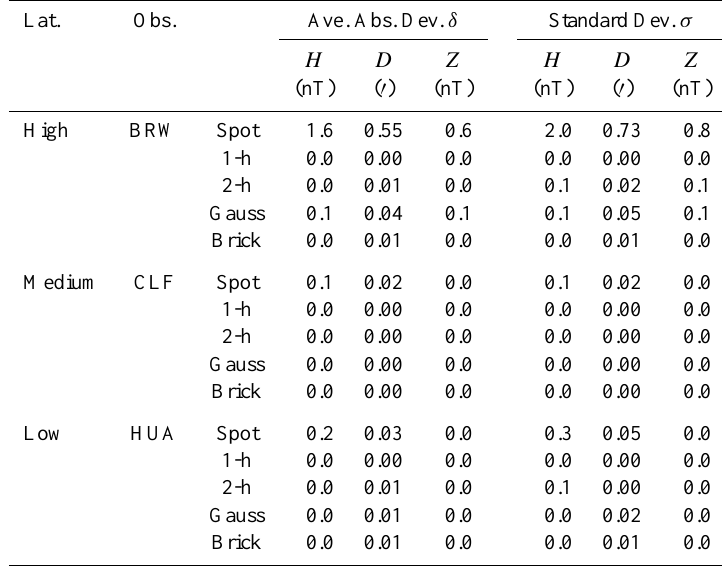
Table 4. Statistics of discrete 685 × 64-min “monthly” differences (cid:15) ?m (t j ) for 1998.0–2009.0. Lat. Obs. Ave. Abs. Dev.